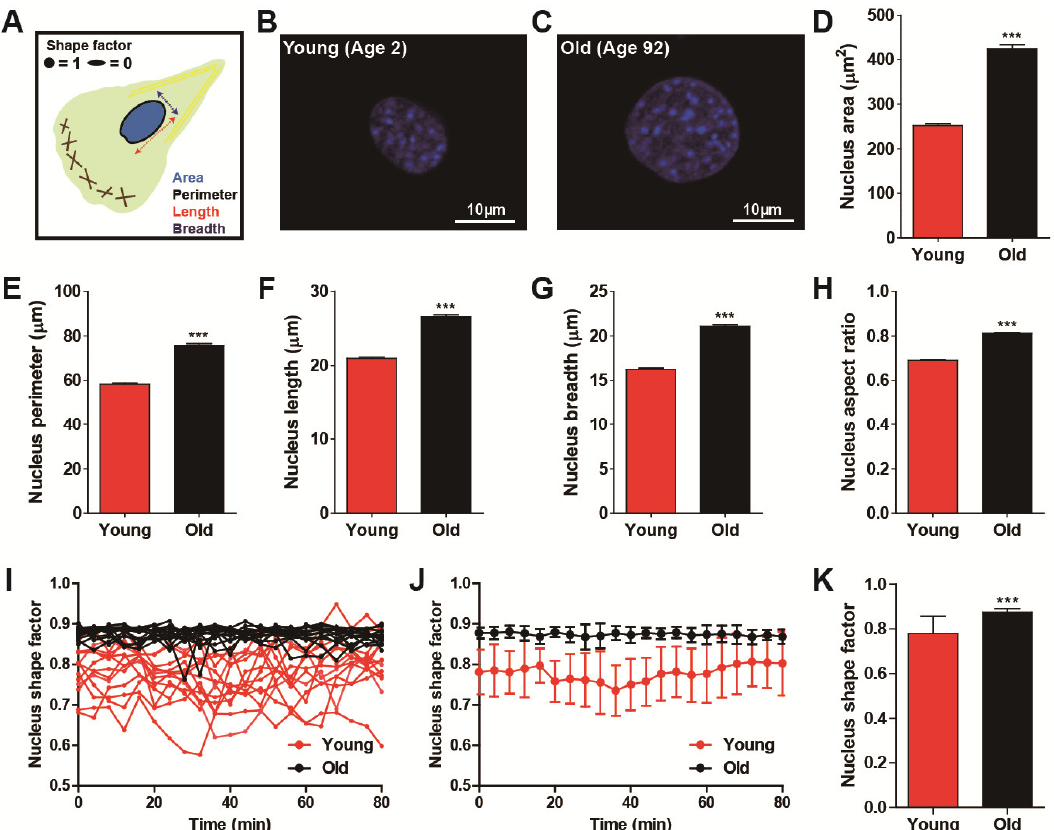
Figure 2. Age-dependent alteration of nuclear morphology. ( A – H ) Morphometric comparison of nuclear morphology between young (age < 5) and old (age > 80) HDFs. Schematic defining of descriptors of nuclear morphology ( A ). Note that shape factor is defined as 4π(area)/(perimeter) 2 , and thus, the nucleus shape factor of elongated and round nuclei approaches 0 and 1, respectively. Representative immunofluorescent images of nuclei of young and old HDFs stained with DAPI ( B , C ). Nuclei of young cells are smaller ( D – G ) and more elongated ( H ) than nuclei of old cells. More than 600 cells were analyzed for each condition. ( I – K ) Time-lapse monitoring of nuclear shape. Fluctuation of nuclear shape changes in young cells is larger than changes in nuclear shape in old cells ( I , J ). Nuclei were imaged using time-lapse fluorescence microscopy, every 4 min, for 80 min. Time-lapse monitoring of nucleus shape factor ( I ) and fluctuation of their average values ( J ) are presented. Average values of time-lapse monitored nuclear shape factor indicate nuclei of young cells are more elongated and they change their shape more dynamically than nuclei of old cells ( K ). More than 10 cells were monitored for each condition (young, 13 cells and old, 15 cells). In panels ( D – H ), error bars indicate S.E.M. and statistical di ff erences were calculated using the unpaired t-test; *** p < 0.001. In panels ( J ) and ( K ), error bars indicate standard deviation (S.D.) and statistical di ff erences were calculated using the unpaired t -test. *** p < 0.001.